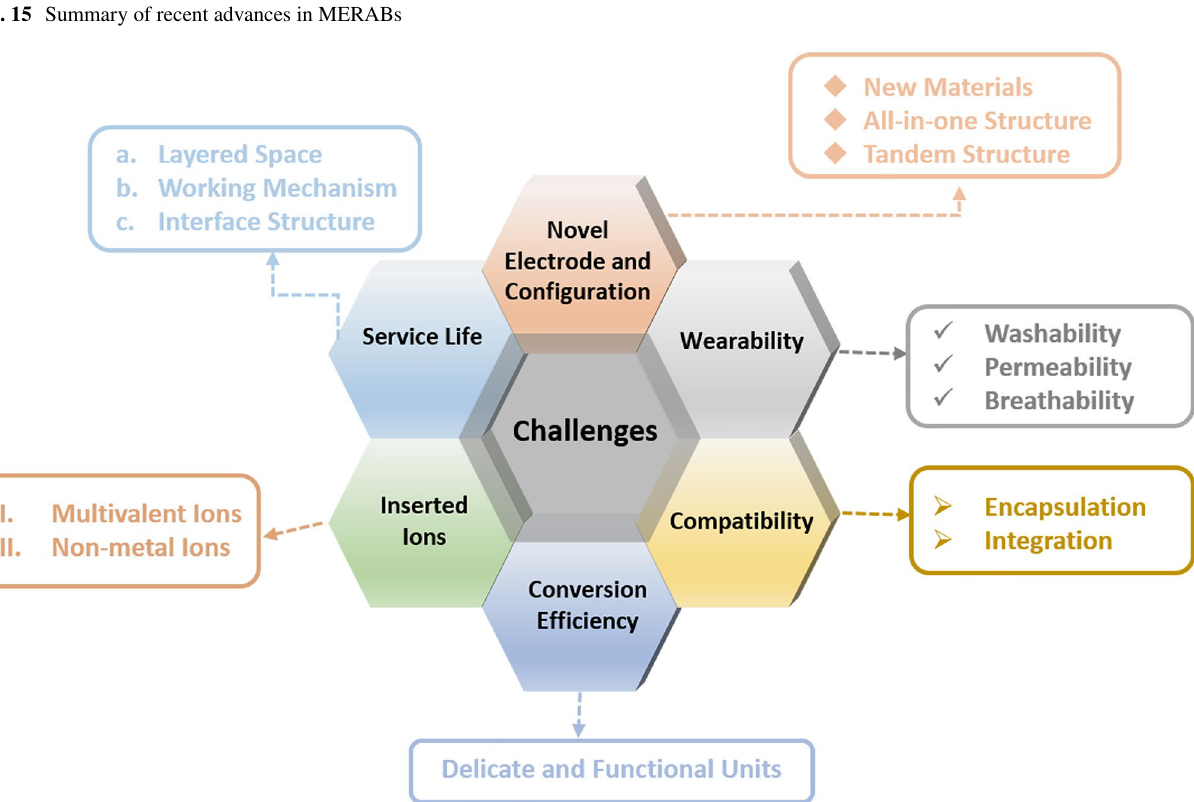
Fig. 16 Schematic diagram of main challenges and development trend of